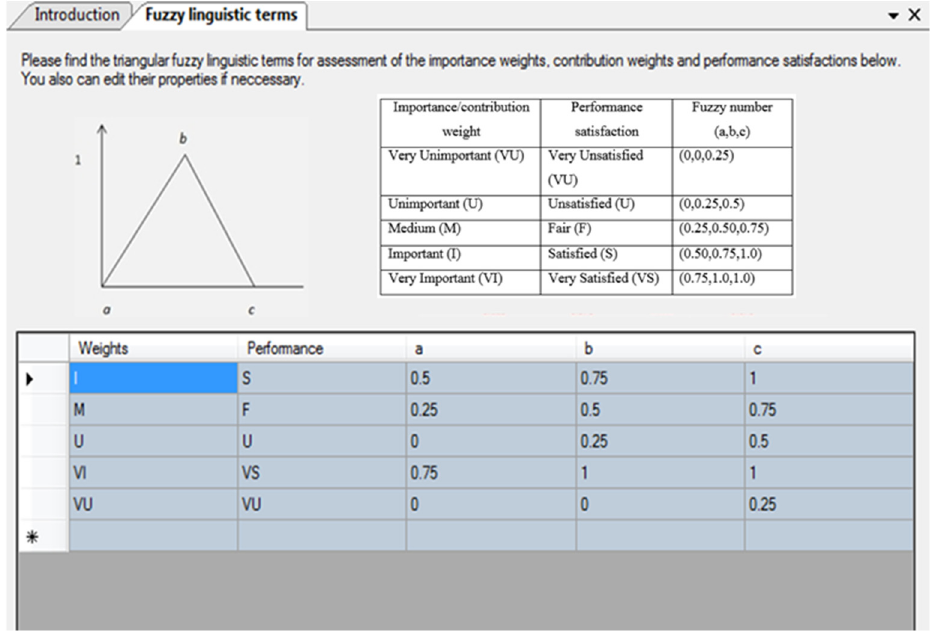
Figure 2. Fuzzy linguistic